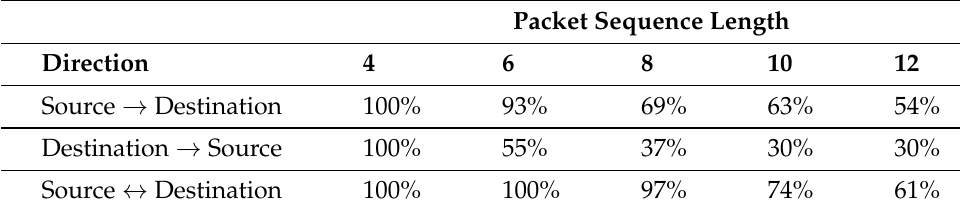
Table 4. Resulting true positive rate (TPR) of different types of signatures against the tested traffic. Signatures and traffic are part of the attack samples from the “Exploits” category. The signatures are generated after a combination of packet direction and packet payload size.